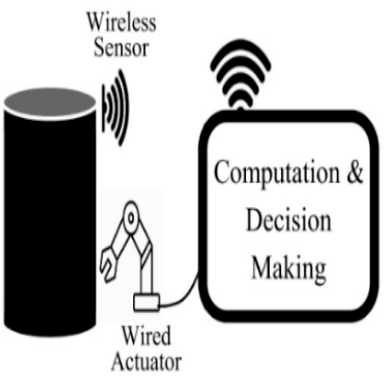
Figure 6. The heterogeneous components of CPS that connected through wired and wireless communication [64].